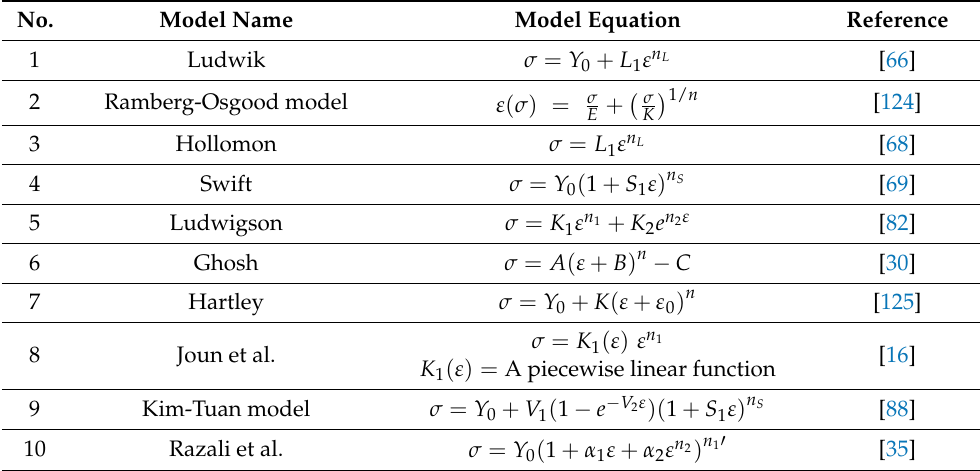
Table 4. Ludwik family models focused on strain hardening.